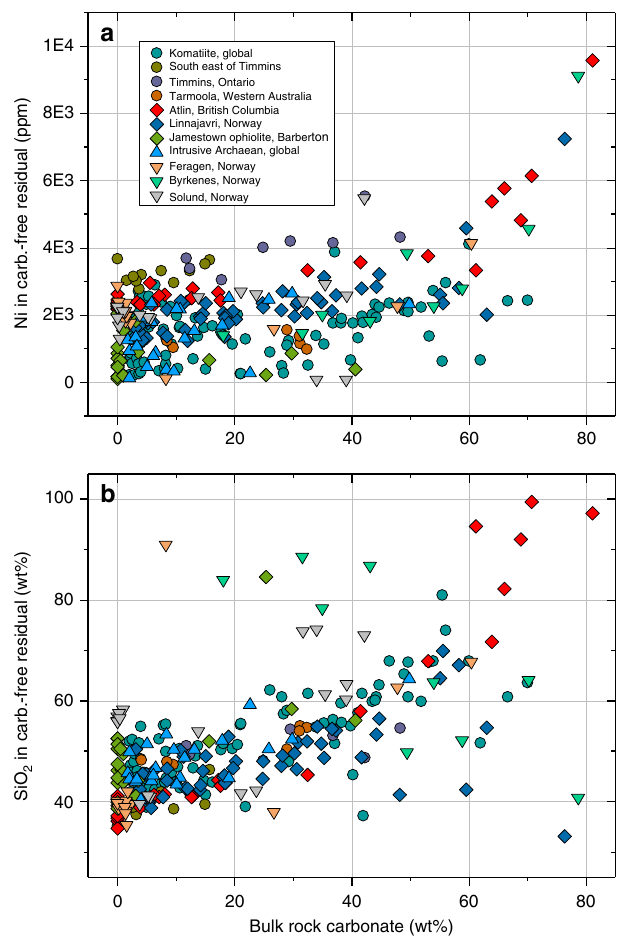
Fig. 5 Ni and SiO 2 enrichment trend during weathering of hydrothermally altered ultrama fi c rock. a Ni and b SiO 2 concentrations in carbonated ultrama fi c rock samples are recalculated on a CO 2 -free basis to reveal the effect of kinetically favoured breakdown of carbonate during weathering. The data set includes Archaean komatiite and intrusive peridotite samples (circles and upward triangle), alpine peridotite (diamonds), and sediment – hosted peridotite boulders from Norway (downward